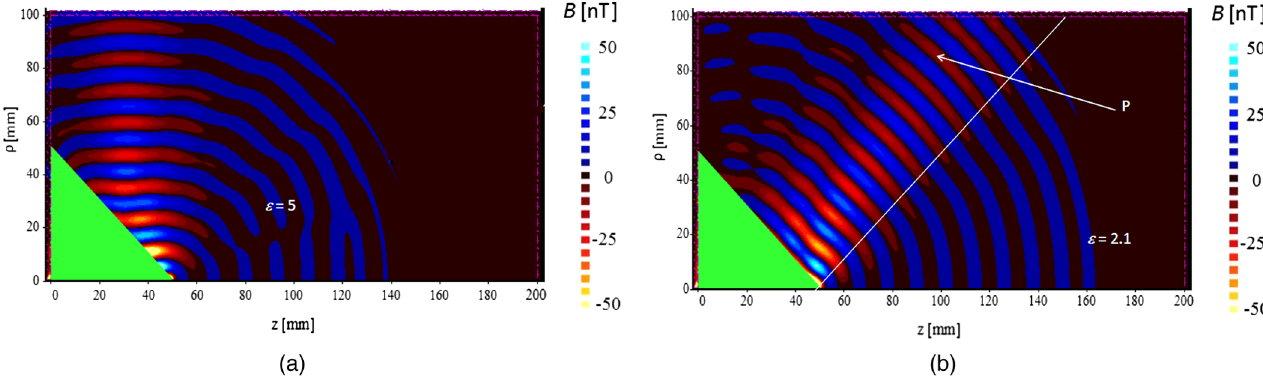
FIG. 2. Simulations performed using MAGIC [27] of CChDR emitted by a 0.5 mm radius hollow dielectric cone. (a): with a relative permittivity ε ¼ 5 . (b): with a relative permittivity ε ¼ 2 . 1 .